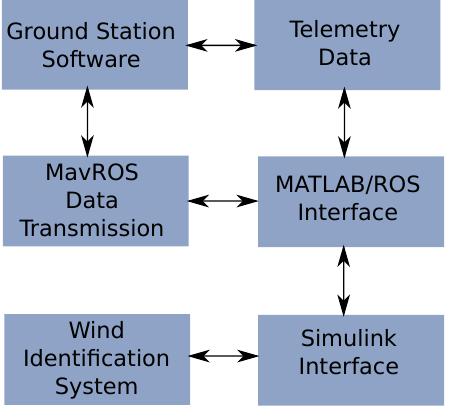
Figure 12. Information flow for on-the-loop experiments of the wind identification system. The blocks show the multi-platform interfaces that allowed the validation tests.